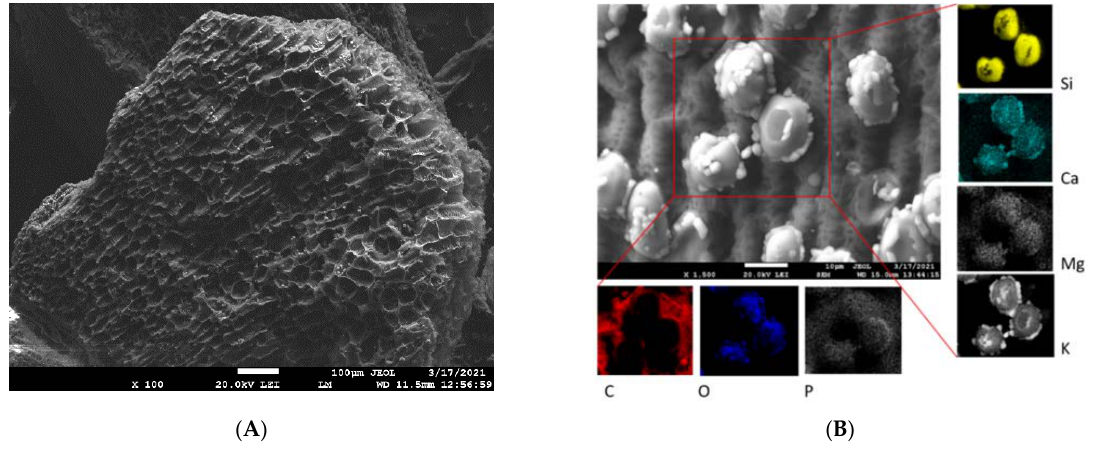
Figure 1. SEM ( A ) and EDX ( B ) images of CC biochar. EDX elemental distribution maps show elemental (C, O, P, Si, Ca, Mg, and K) composition of area closed by red lines in panel ( B